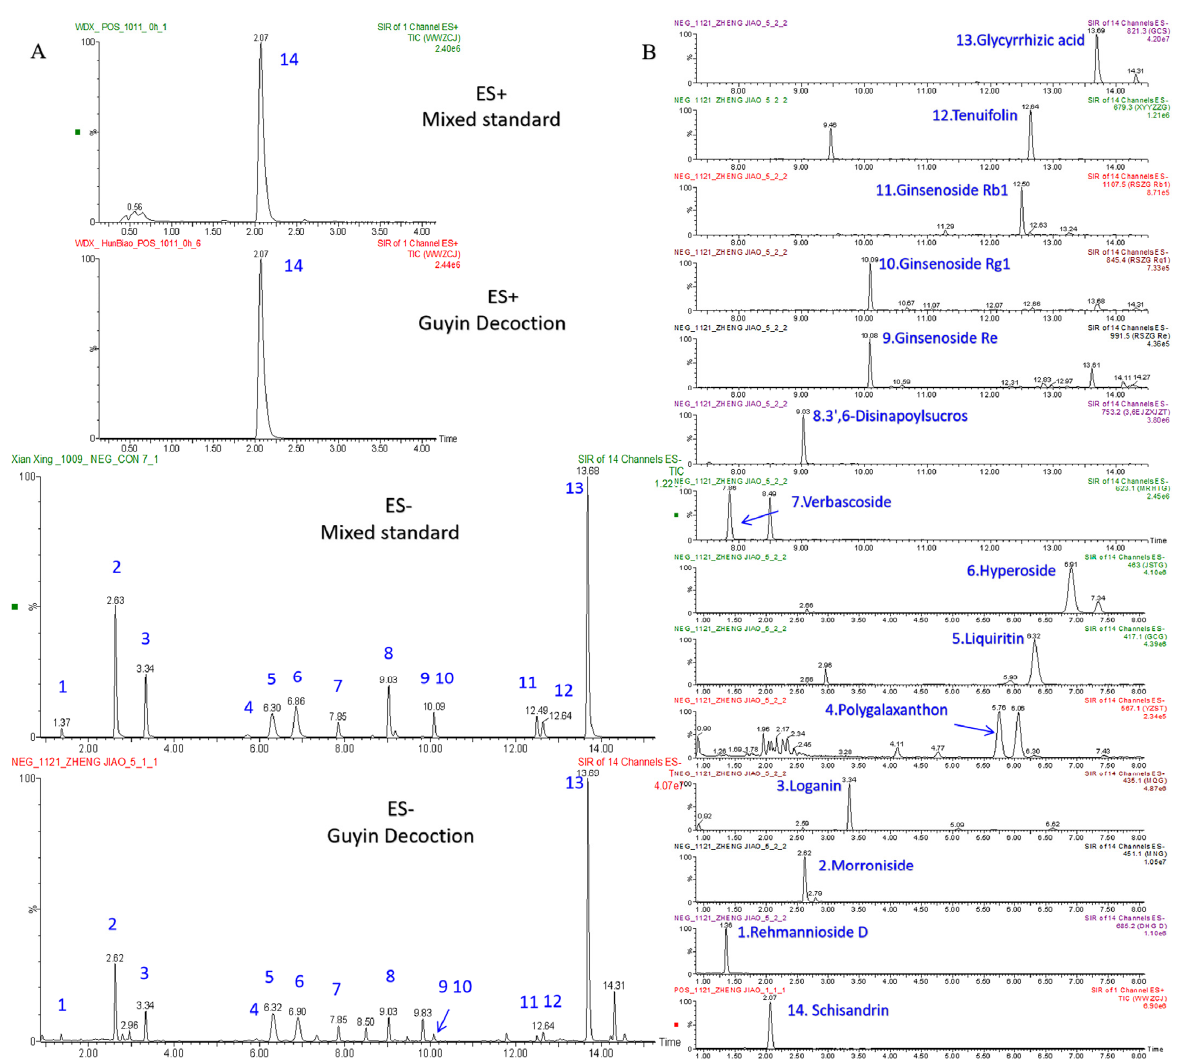
Figure 2. Representative chromatogram. ( A ) Total Ions Chromatograph (TIC) of the mixed standards compared with the GYJ samples. ( B ) Chromatograms of individual extracts of each compound in GYJ samples. Table 1. Summary of UPLC-MS-SIR mode parameter information for 14 compounds. Table 2. Calibration curve, linear ranges, and r study results of 14